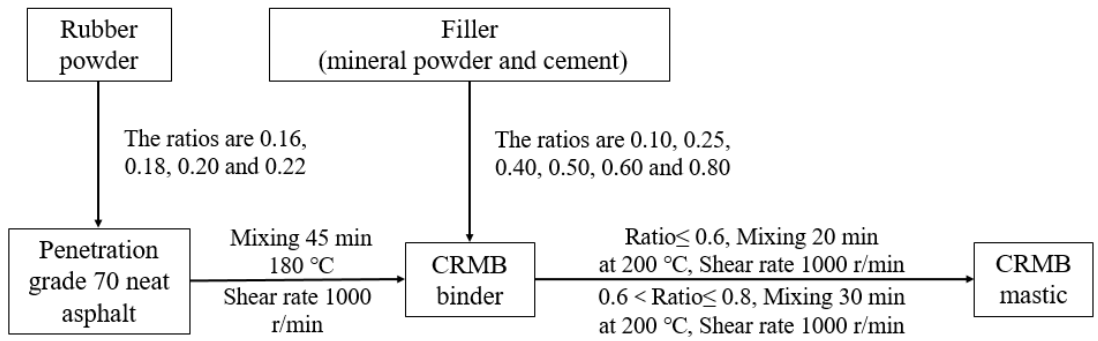
Figure 1. Preparation processes of the crumb rubber modified bitumen (CRMB) binder and the CRMB mastic.